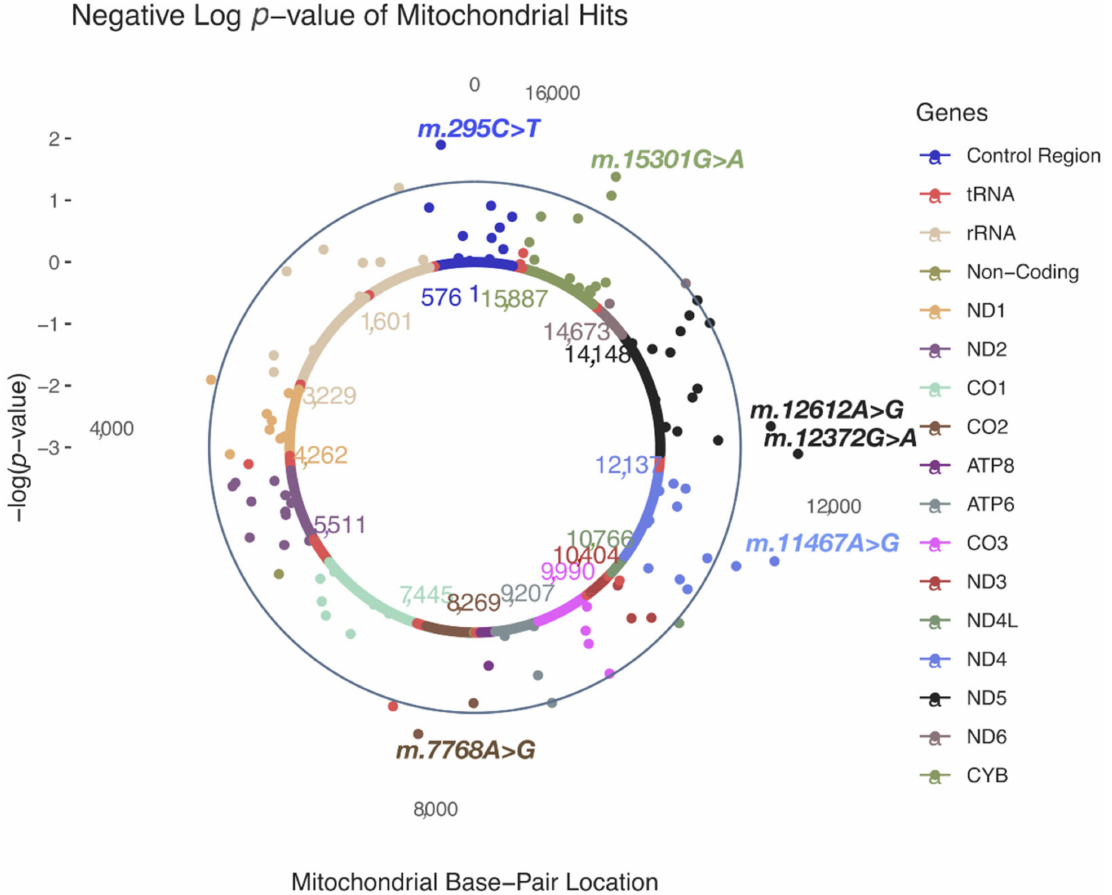
Figure 2. A solar plot of HARD CAD common and low-frequency (MAF > 0.01; n = 111) MT-SNV associations. Table 3. SOFT CAD common and low-frequency (MAF > 0.01; n = 111) MT-SNV most